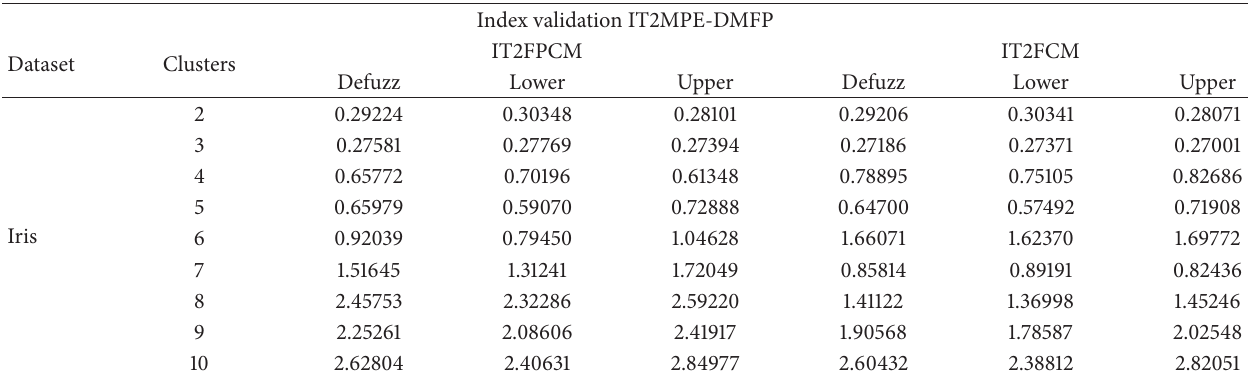
Table 9: Results of the IT2MPE-DMFP validation index to Iris Flower dataset clustering using IT2FPCM and IT2FCM algorithm with 𝑚 = [1.5, 2] and 𝜂 = [1.5, 2.5] as